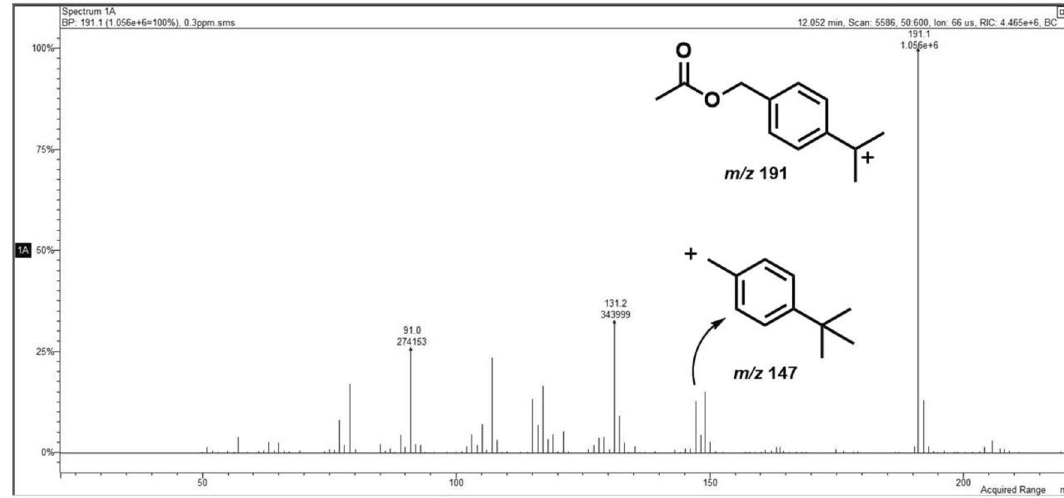
Fig. 3 The EI mass spectrum of 4- t -butylbenzyl acetate (MW